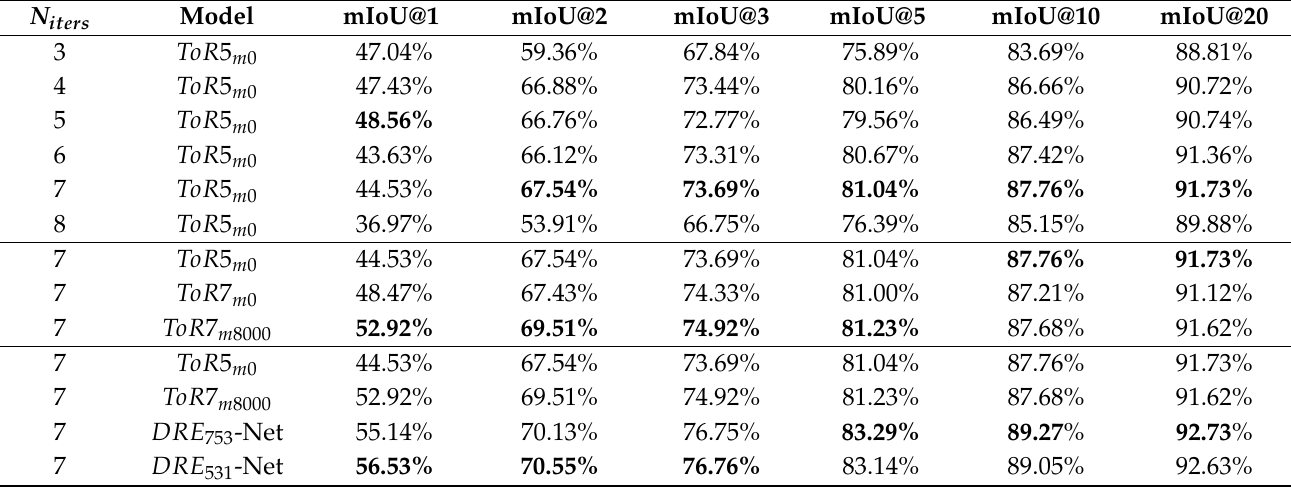
Table 7. Test results on the Potsdam dataset under different thresholds N iters and different hy- perparameters min _ object . ToR 7 m 8000 stands for the model trained on a radius of 7 pixels and min _ object = 8000. mIoU@k represents the mean intersection over union (IoU) between the predic- tions and ground-truth masks at the kth iteration. (The best is